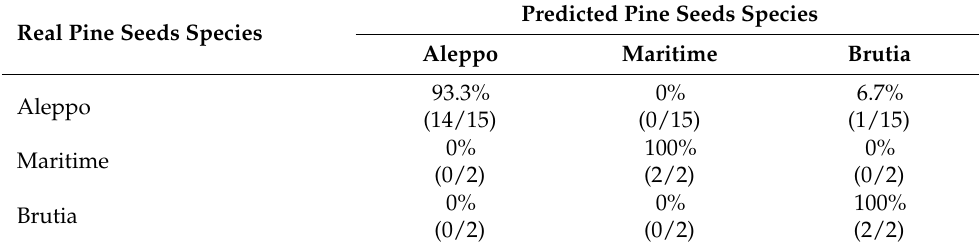
Table 3. Confusion matrix for the best PLS-DA pine seeds species discrimination model based